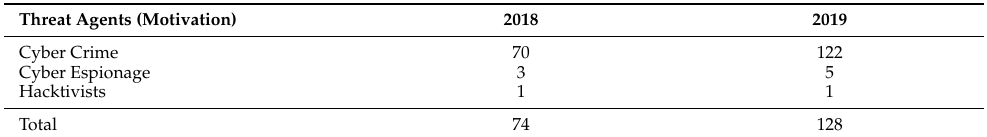
Table 12. Threat agents from 2018 and 2019, reported by Hackmageddon.com (Visited 28 January